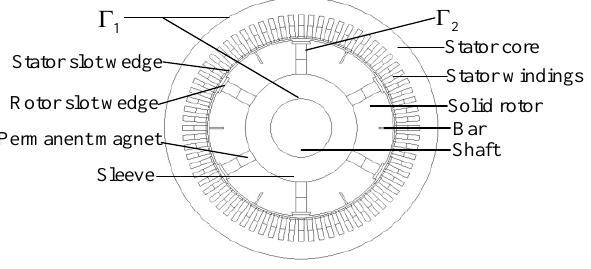
Figure 2. 2D electromagnetic analysis model of HVLSSR-PMSM.